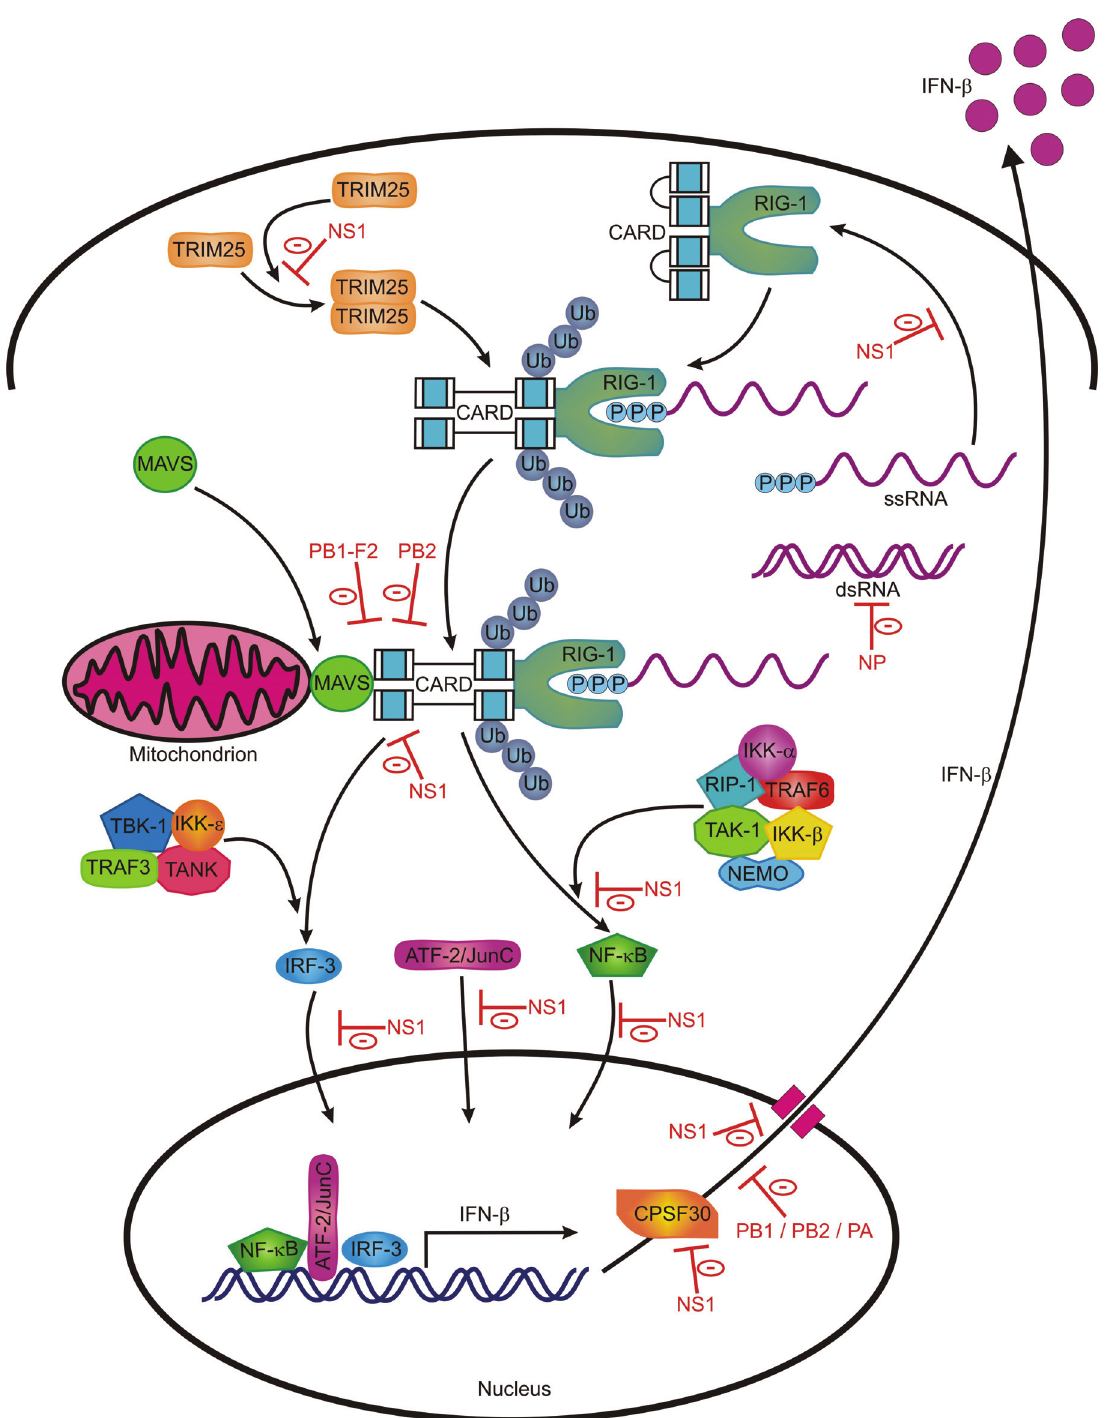
Figure 2. The RIG-I signaling pathway and inhibition by influenza A viruses (Figure adapted from [48]). By-products of viral replication are 5'-triphosphates ssRNA and dsRNA which can bind to the RIG-1 receptor, leading to conformational changes, causing exposure of the CARDS which are ubiqutinated by TRIM25. Subsequently, RIG-1 associates with MAVS and thereby starts a signaling cascade leading to activation of transcription factors IRF3, NF- κ B and ATF-2/JunC, resulting in the transcription of IFN- β mRNA. Indicated in red are sites at which the influenza A virus interferes with this pathway, as explained in the